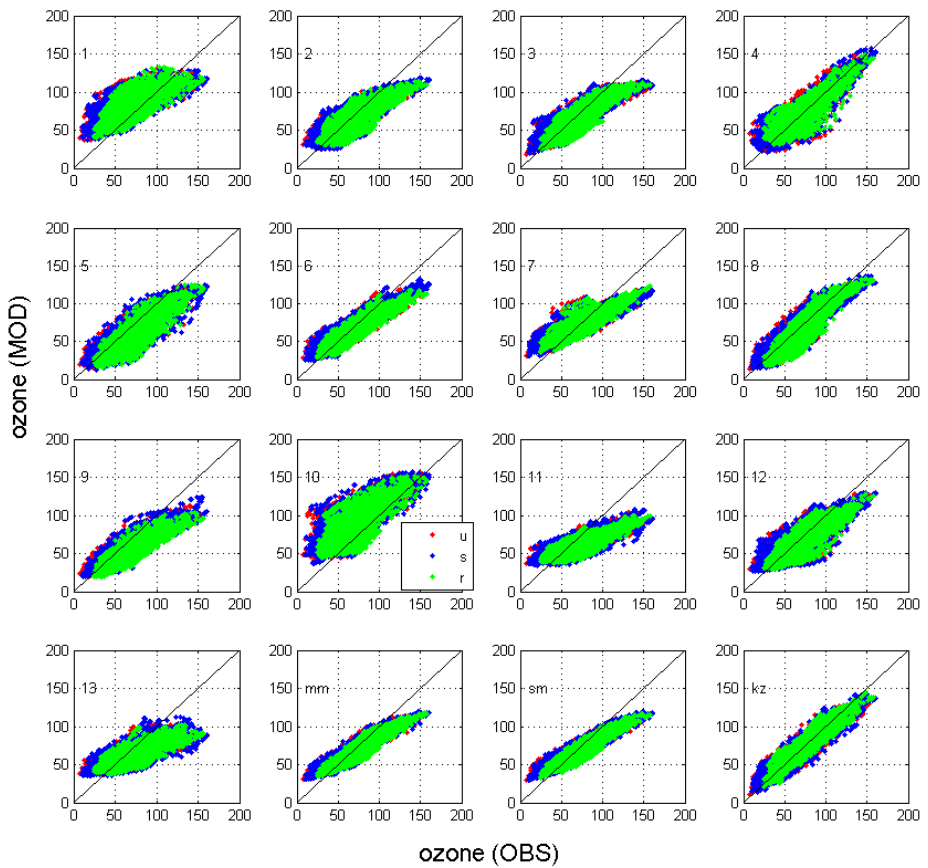
Fig. 8. Scatterplot of all examined cases corresponding to the prediction week, for the EU1 sub-domain and all three ozone aggregation types. Compared to the rest of the models, the cloud of the kz model scatter is tilted towards the diagonal. Table 6. Decomposition of the kz model error into the spectral components (% of total error). URBAN SUBURBAN